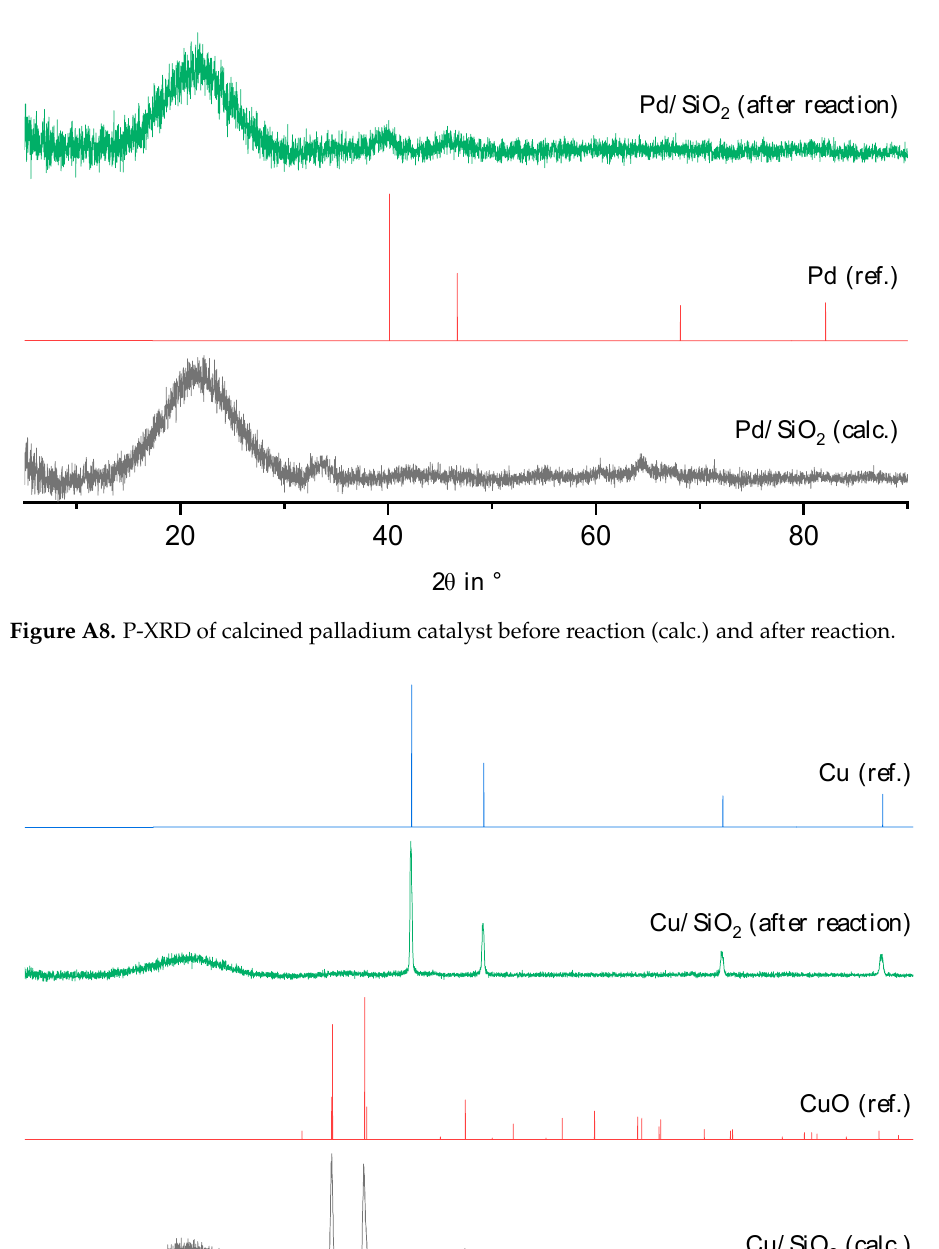
Figure A7. P-XRD of calcined nickel catalyst before reaction (calc.) and after reaction.